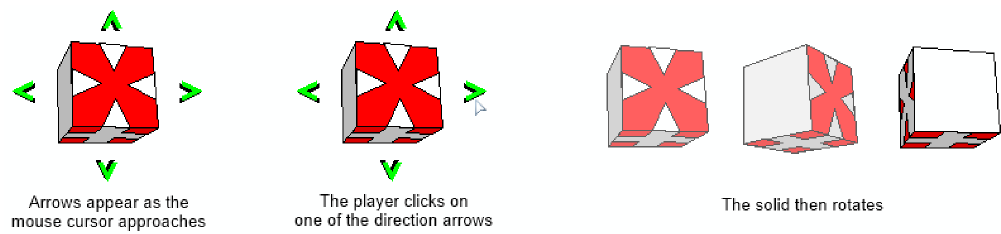
Figure 6. An example of rotating the cube when the type of agency is manual.